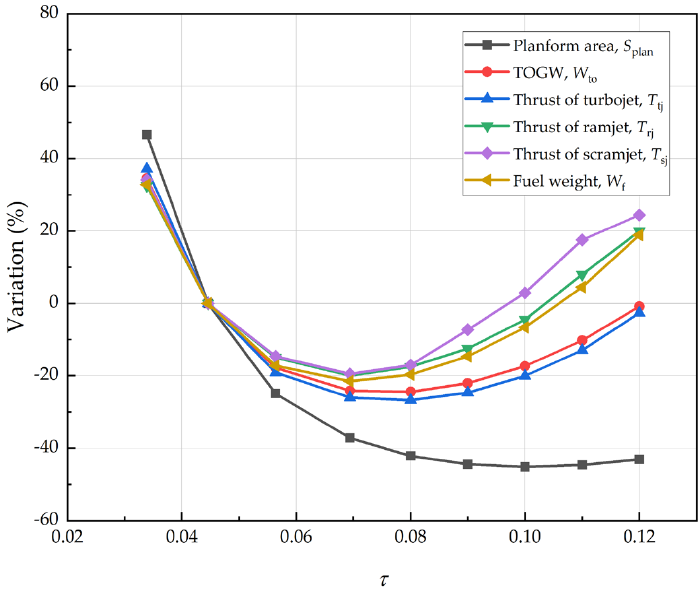
Figure 14. Impacts of the Küchemann slenderness parameter τ on the takeoff gross weight, planform area, and thrust.